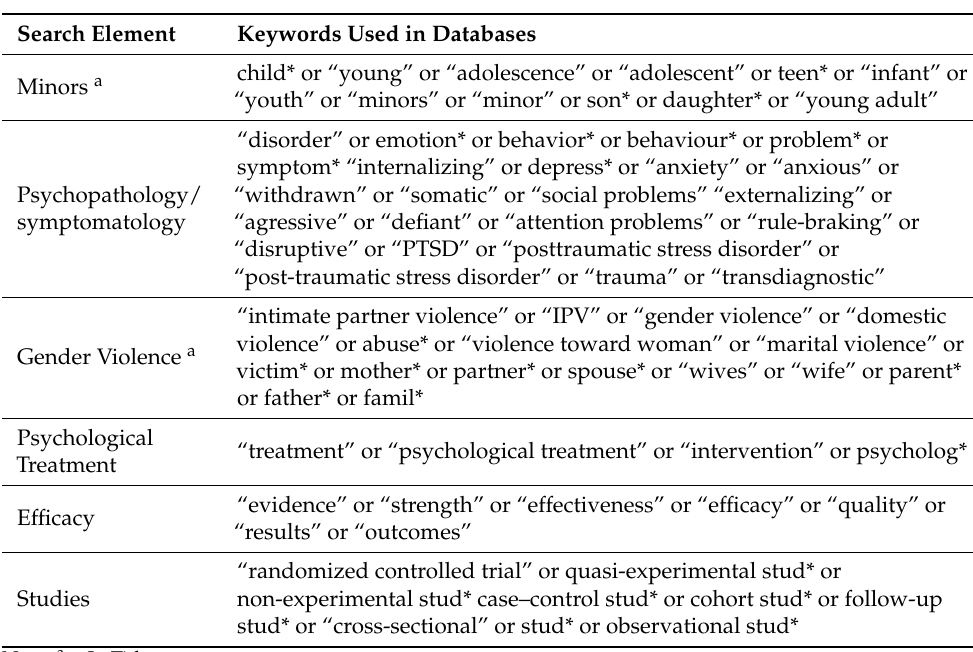
Table A1. Search elements for systematic review.